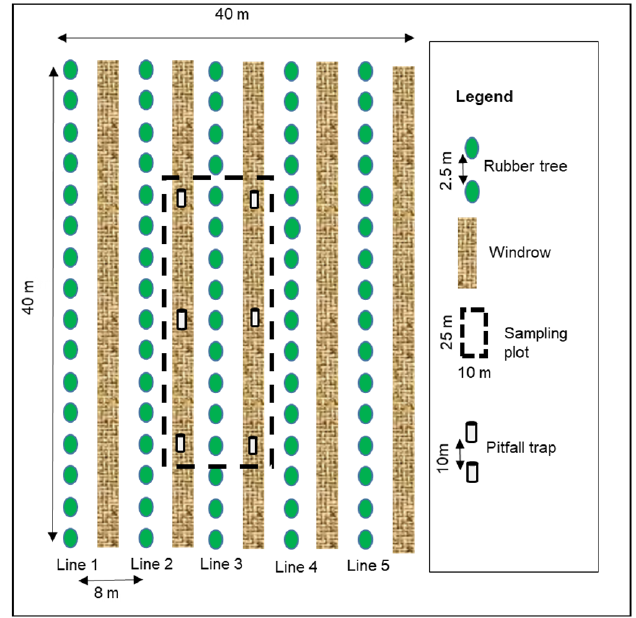
Figure 1. Sampling design in each plot.